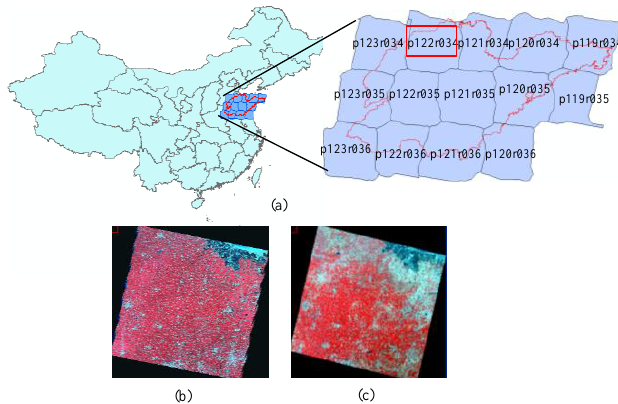
Figure 4.Study area (a) and Landsat imagery of p122r034: Landsat5 TM (b), Landsat8 TM (c)